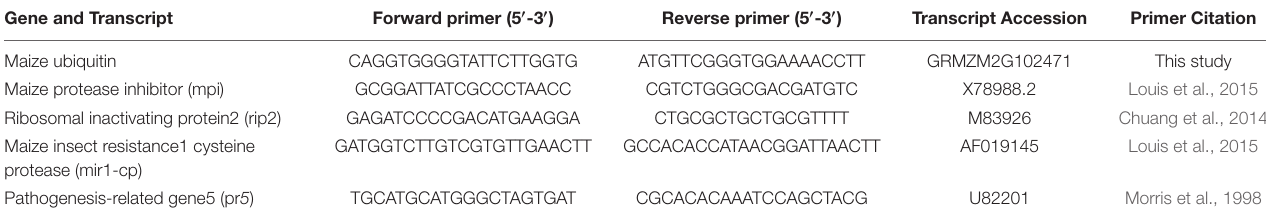
TABLE 1 | Primers used in this study for rt-PCR. Gene and Transcript Forward primer (5 (cid:48) -3 (cid:48) ) Reverse primer (5 (cid:48) -3 (cid:48)